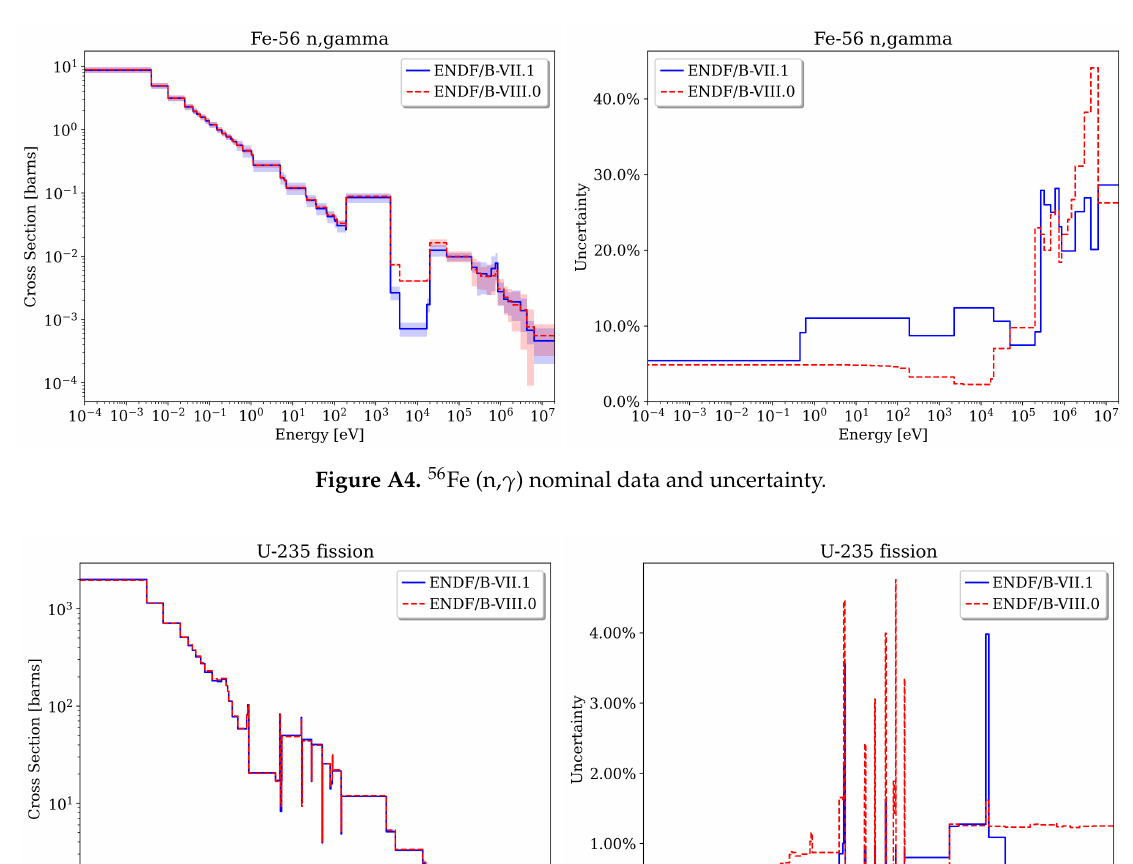
Figure A3. 56 Fe elastic scattering nominal data and uncertainty.